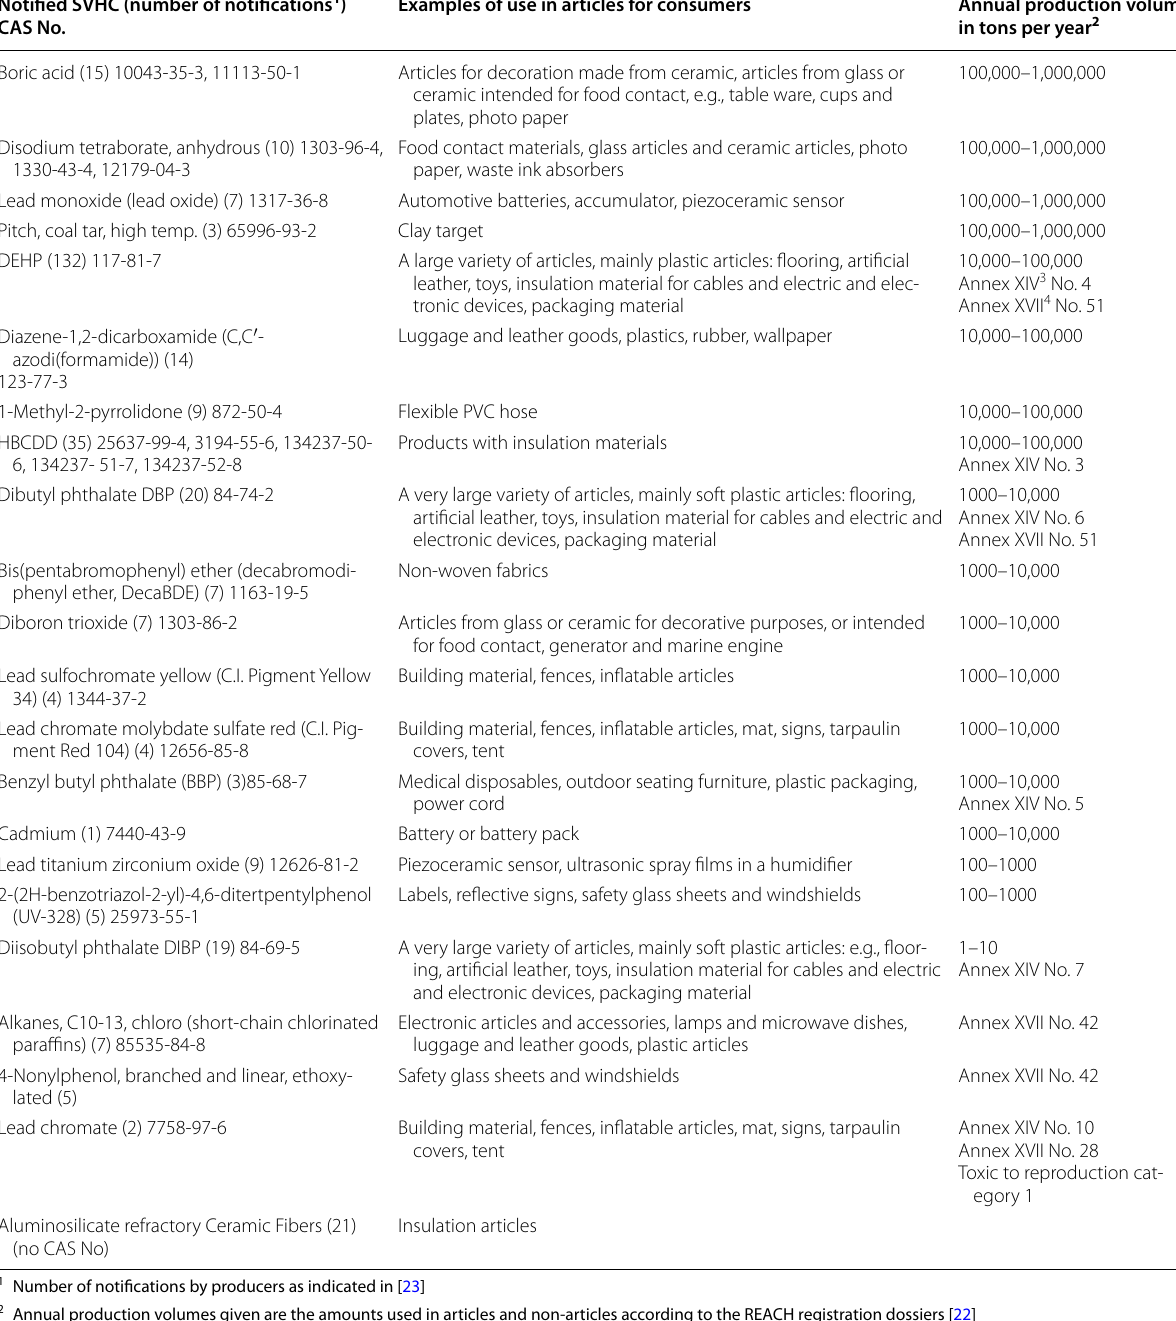
Table 1 Examples of SVHCs in consumer articles and notifications by